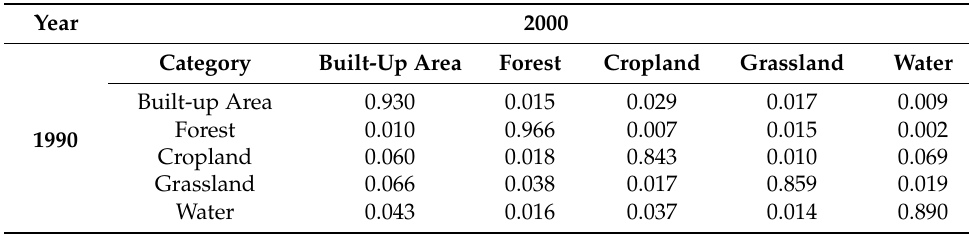
Table 7. Transition Matrix from 1990–2000.